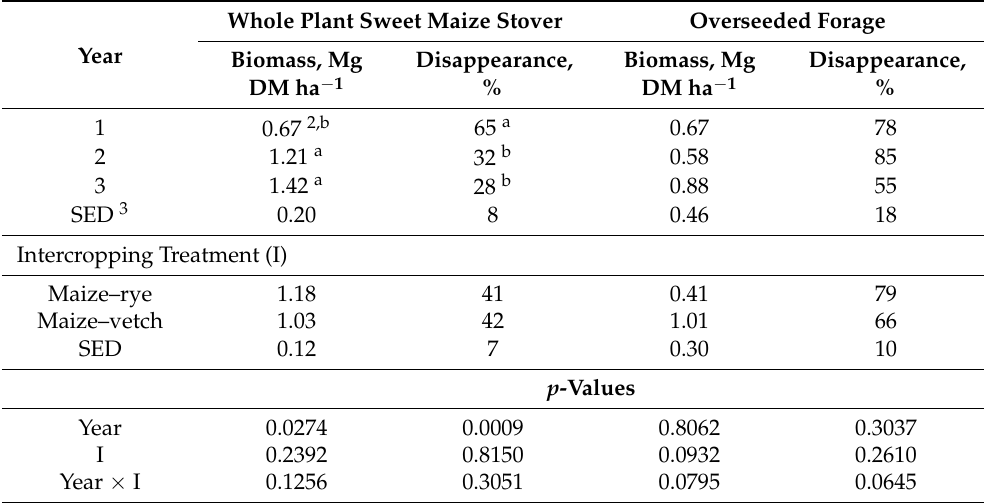
Table 3. Relay intercropping treatment main effect means of post-grazing (late May) biomass dry matter (DM) yield and percentage disappearance of sweet maize stover intercropped with rye or hairy vetch and the intercropping forage species over three years at Alcalde, NM, USA 1 . Whole Plant Sweet Maize Stover Overseeded Year